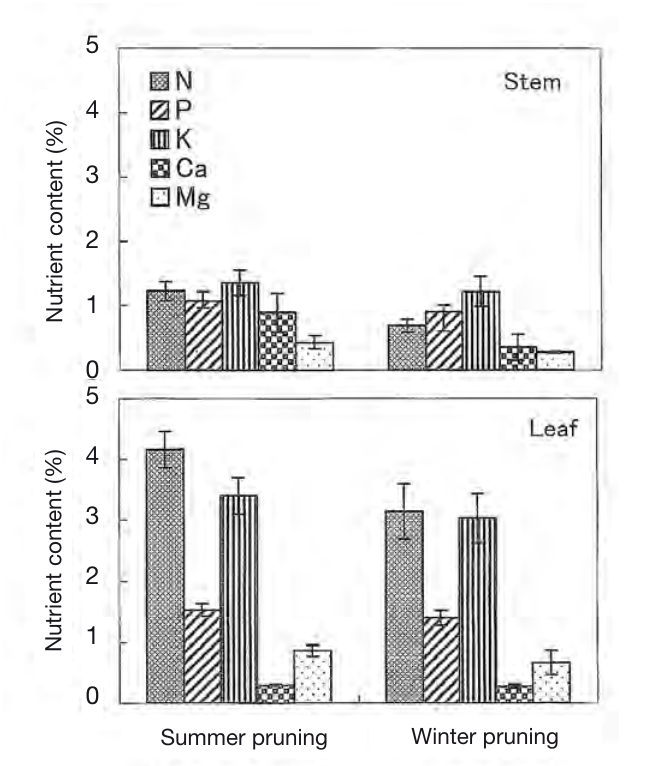
Fig. 5 - Effect of summer and winter pruning on mineral content of stems and leaves in peach trees on 4 April. Data are presented as mean ± standard error ( se ).